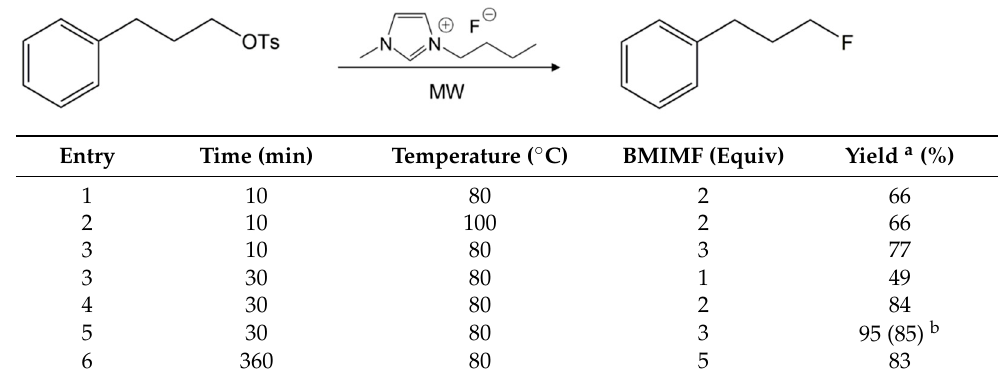
Table 6. Fluorination of 3-phenylpropyl p-toluenesulfonate with [bmim][F].